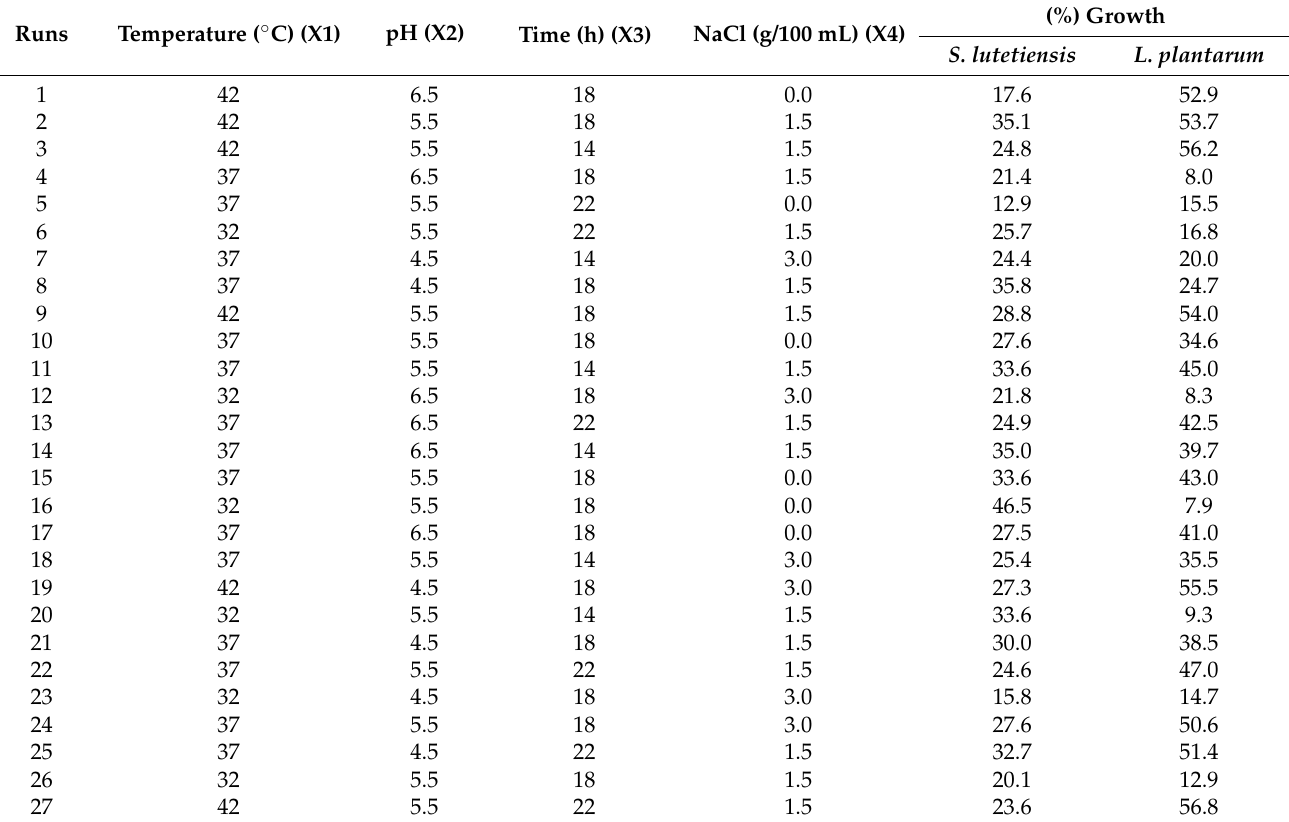
Table 1. Box–Behnken experimental design with coded variables and the responses of acrylamide removal (%) for S. lutetiensis and L. plantarum under anaerobic condition.